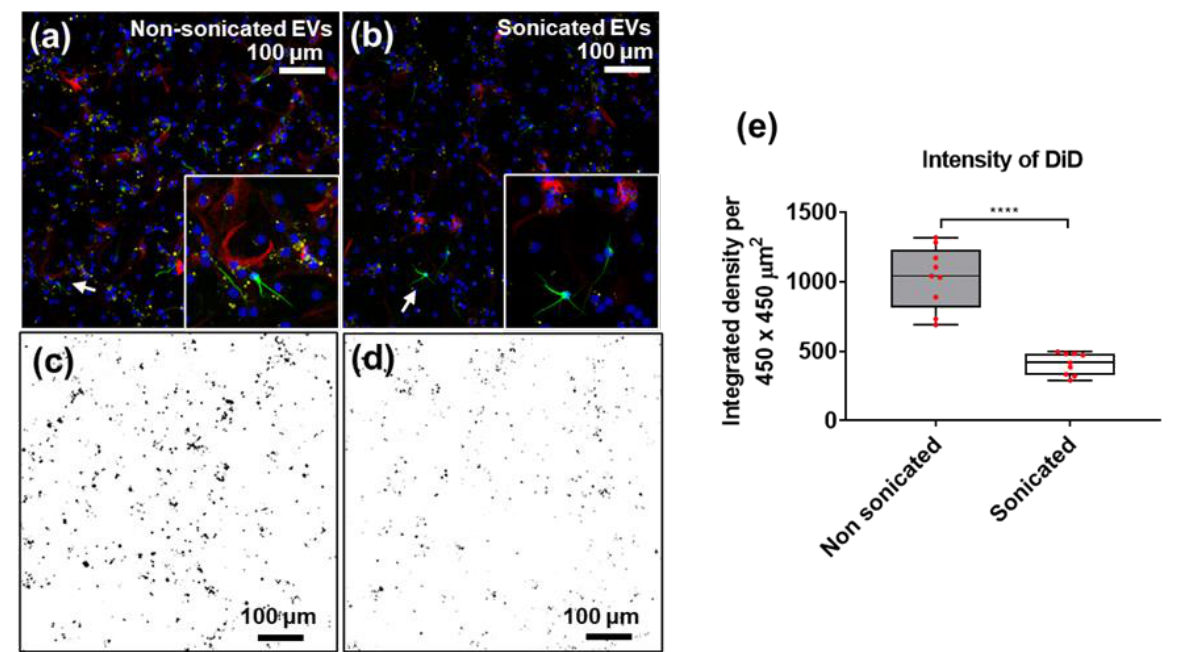
Figure 5. Immunofluorescence images of NSC-derived EV (DiD, yellow) uptake by differentiating neural cells labelled with βIII-Tubulin (green) and GFAP (red) at day 10, with DAPI (blue) used as nuclear counterstain. Differentiating neural stem cells incubated with ( a ) non-sonicated and ( b ) sonicated NSC-derived EVs (white arrows point to areas shown in inserts). ImageJ thresholding of DiD channel for ( c ) non-sonicated (in ( a )) and ( d ) sonicated (in ( b )) EVs taken up by cells in culture. ( e ) Quantitation of DiD intensity in ( c ) and ( d ) (red dots represent individual fields of view); N = 9, unpaired students t-test, two-tailed non-parametric; **** p < 0.0001 . Image J (https://imagej.nih.gov/) (accessed on 16 December 2018) was used for thresholding (Min 40, Max 255).